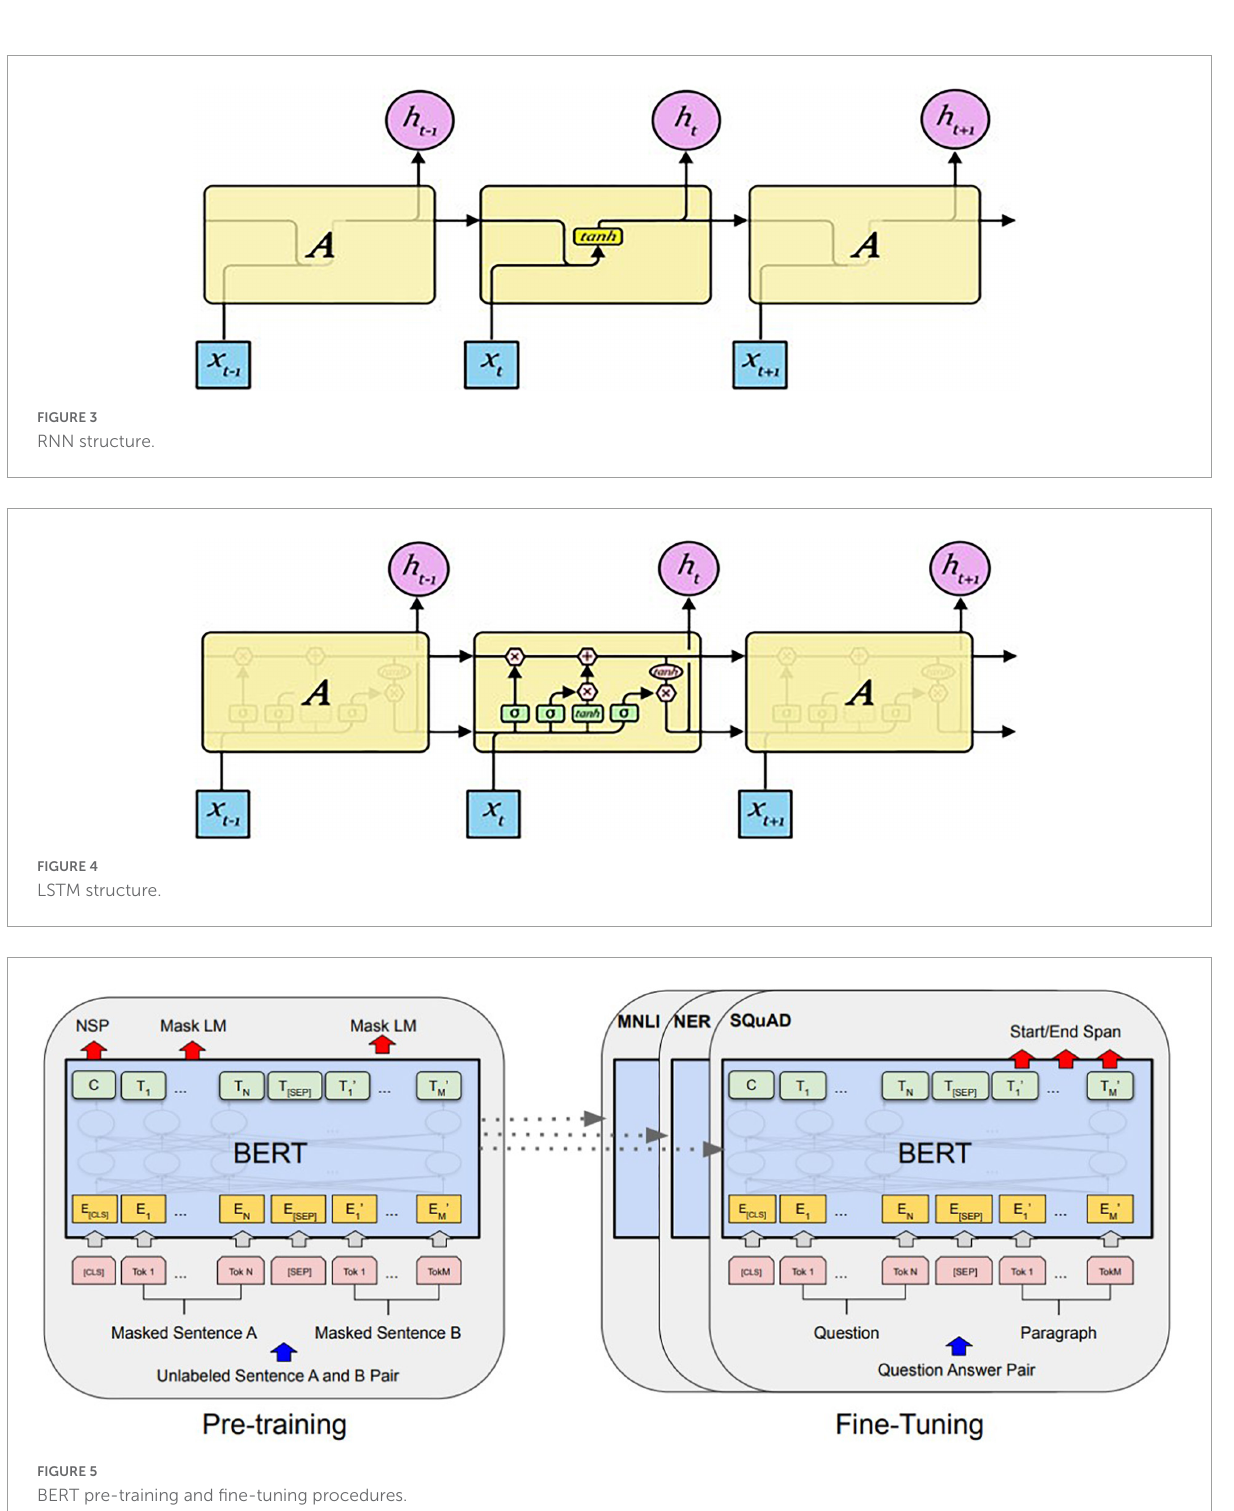
models such as DNN and RNN, even if the model is not linked to a high-computational model such as CNN or LSTM. Both tokenization and modeling were used in the built-in functions of the pre-trained Transformer-BERT